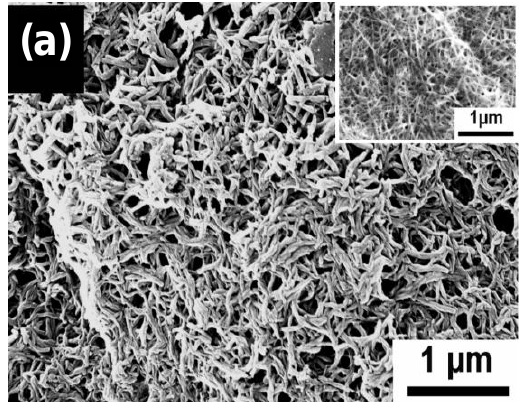
Figure 6. SEM images of PANI nanofibers synthesized with nanofiber seeds (insets): ( a ) single-walled carbon nanotubes; ( b ) V from [39]; Copyright 2012, American Chemical